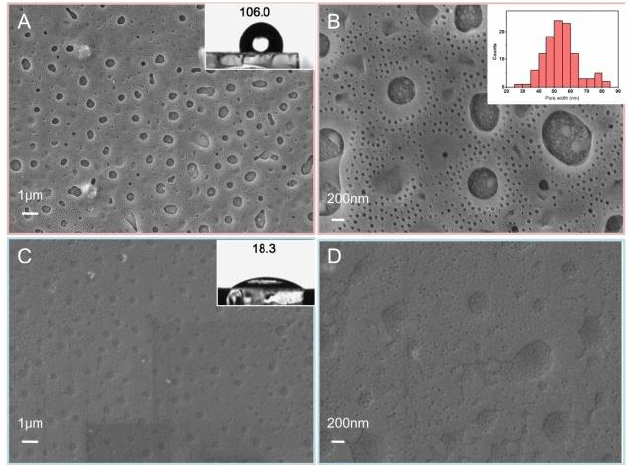
Figure 2. SEM images of PS- b -P4VP film ( A , B ) and GOx/PS- b -P4VP composite film ( C , D ) with different magnification; contact angle images of PS- b -P4VP film (inset A ) and GOx/PS- b -P4VP composite film (inset C ); size distribution of nanopores in PS- b -P4VP film (inset B ). (inset C ); size distribution of nanopores in PS- b -P4VP film (inset B